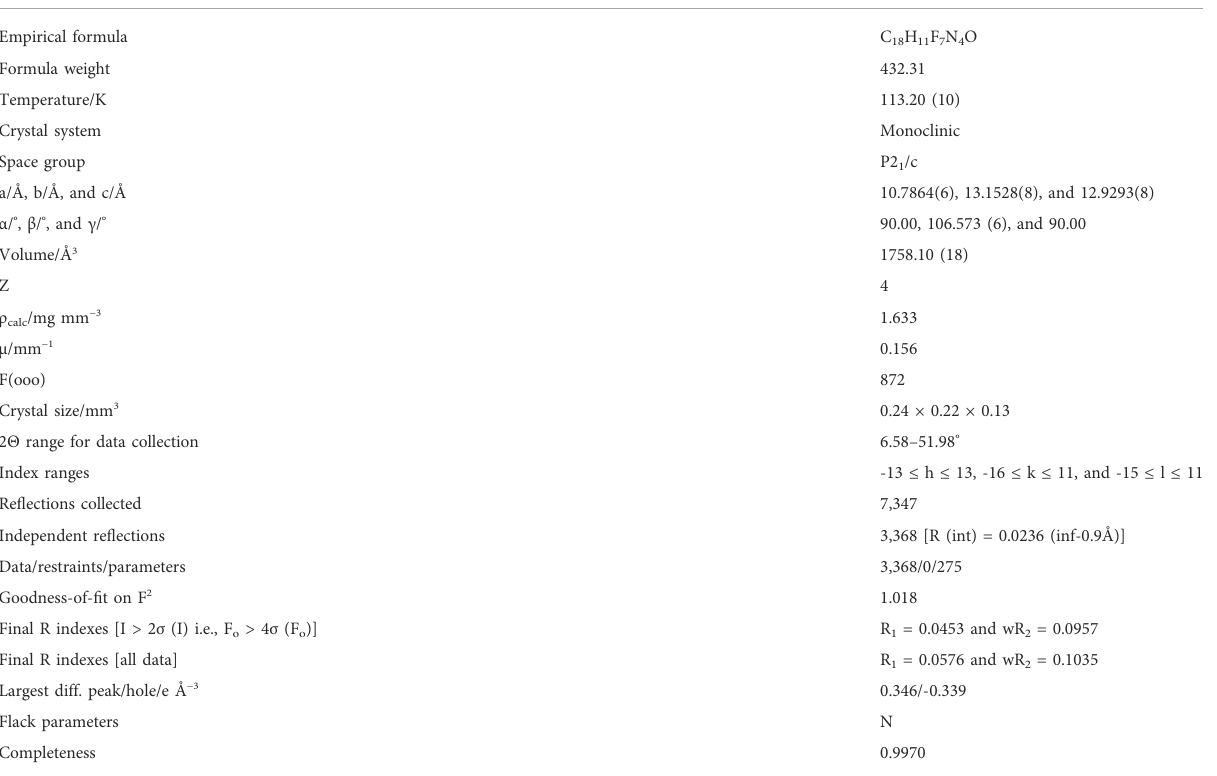
TABLE 1 Structural parameters of compound